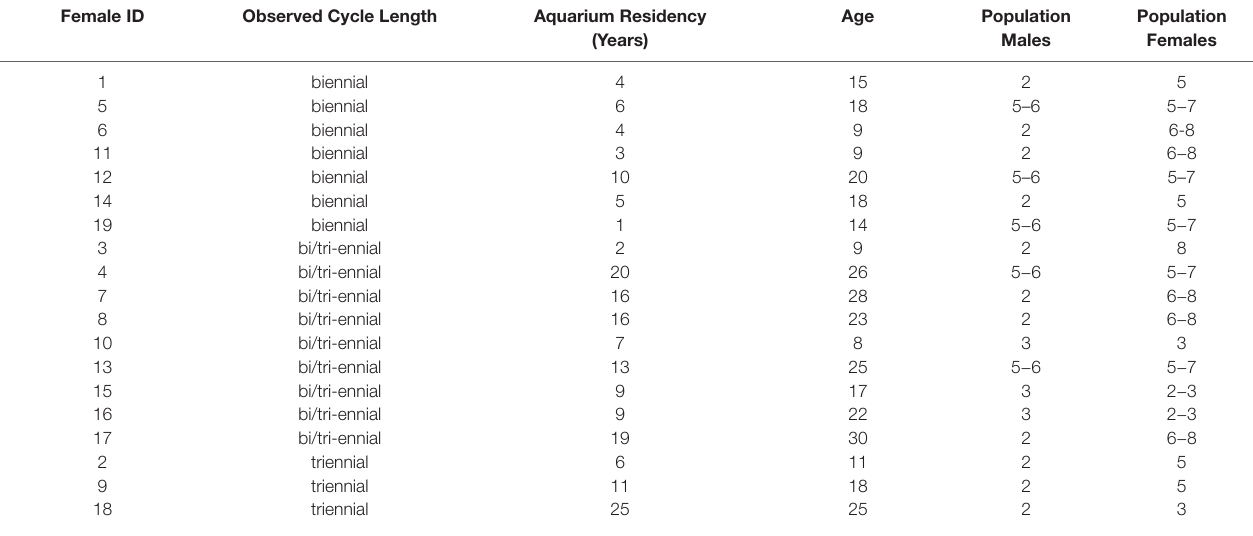
TABLE 6 | Reproductive cycle length and demographics of longitudinally monitored aquarium sand tiger sharks Carcharias taurus . Female